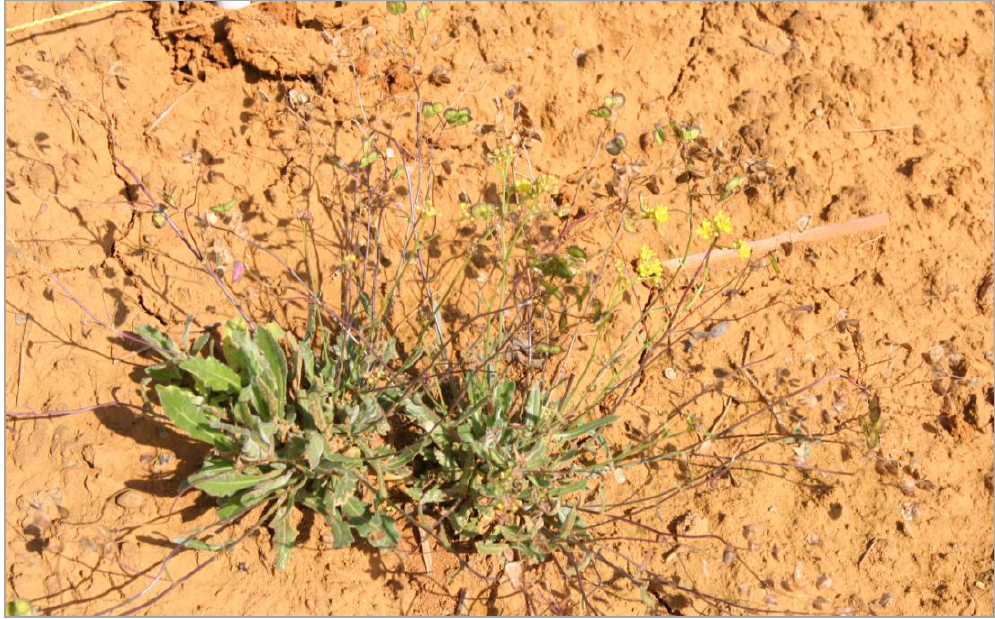
Fig. 12. Flowering plant in the summer of 2013 ( A. Rostański